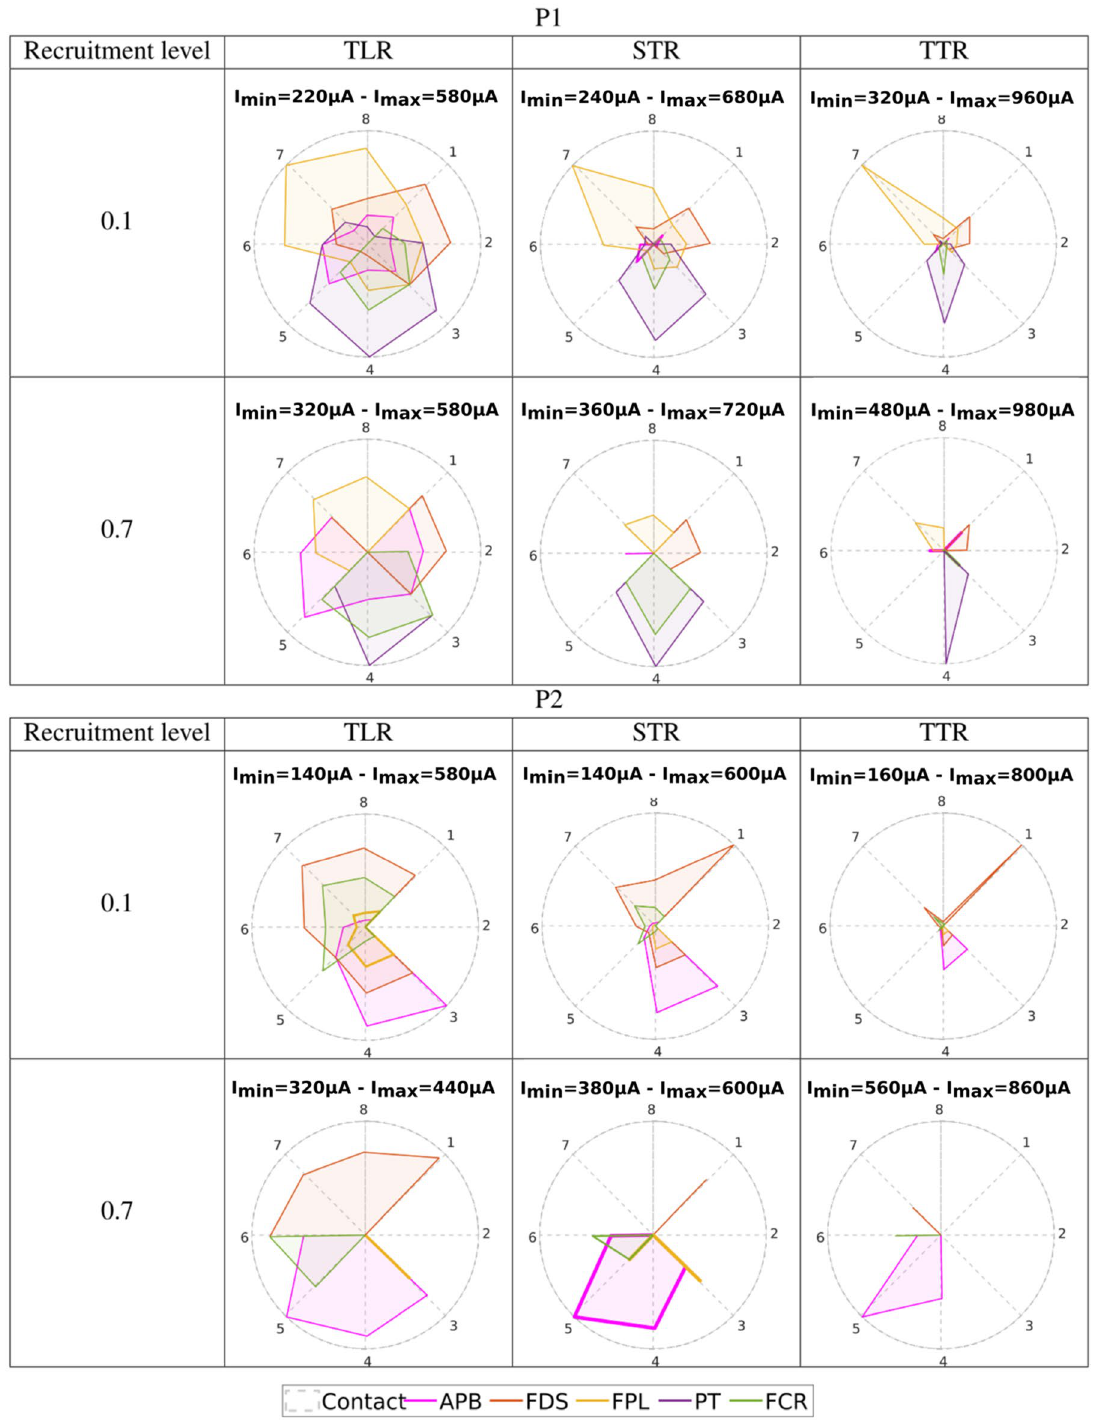
Figure 1. IRO of the muscles for the 3 configurations (TLR, STR, TTR) and for 2 recruitment levels (0.1 and 0.7). From top to bottom: P1, P2 median nerve—P1, P2 radial nerve—Imin values. Each vertex of one colored polygon corresponds to the IRO values for the selected cathode of the considered muscle. The smaller the polygon surface is, the higher the current needed to obtain a recruitment level of 0.1 resp. 0.7 is. A vertex on the circle edge means that Imin, the minimum current amplitude for this configuration, is needed to obtain the given level of recruitment whereas a vertex tied to the center means that the level of recruitment cannot be obtained. In between, along a radius, the sequence of activation with increasing intensities for a given level of recruitment can be seen from edge to